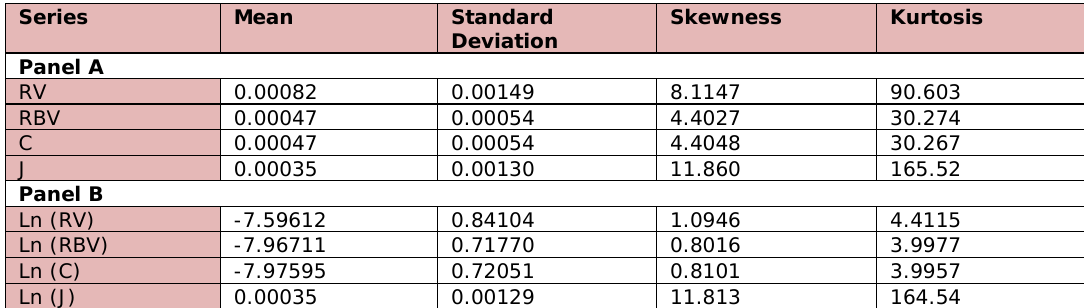
Table 1. “Descriptive statistics of realized volatility levels”. Source: Own